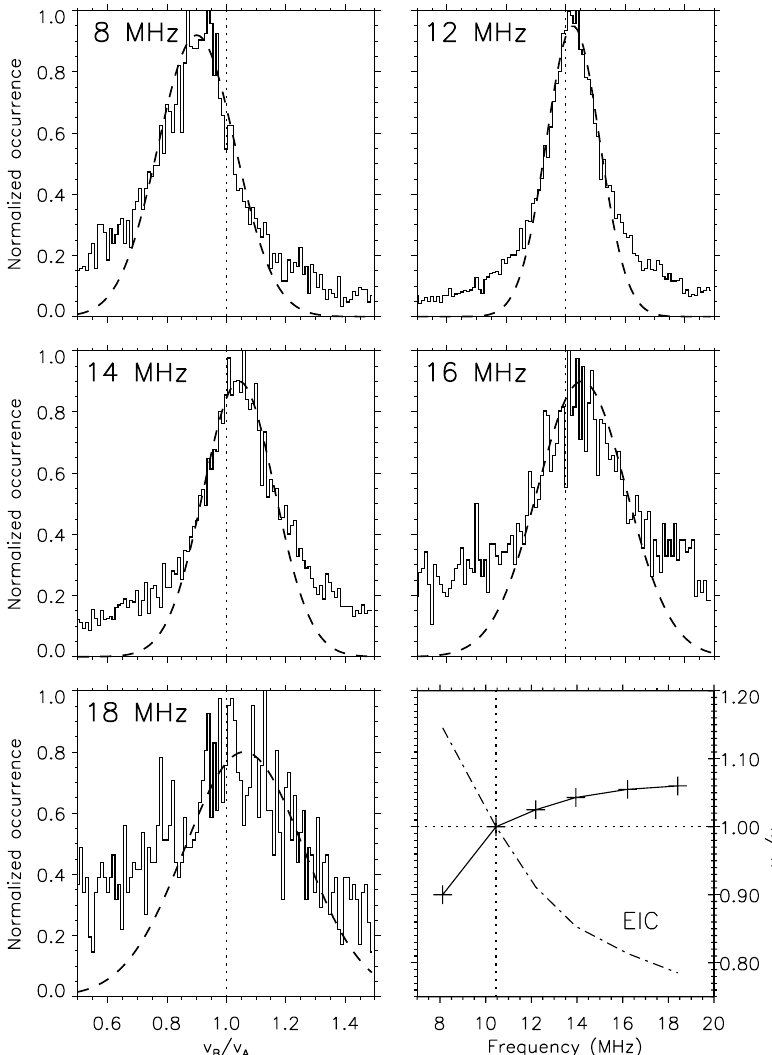
Fig. 13. Occurrence distributions of the ratio ν B /ν A for high-Doppler shift echoes of Fig. 8 (region 1). Superimposed on each is a best- fit Gaussian (dashed curve). (Bottom right) The variation of ν B /ν A with radar frequency (solid curve and crosses). Superimposed is the expected variation for electrostatic ion cyclotron waves (dot-dashed